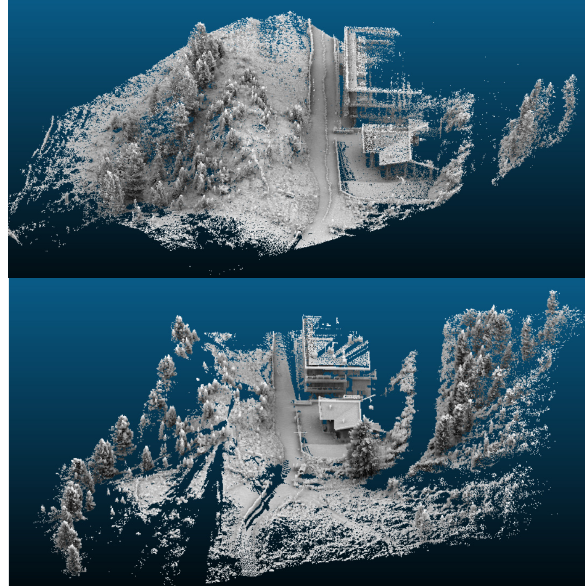
Figure 4. Visual comparison of point clouds from backpack LiDAR (upper) and terrestrial laser scanning (lower)